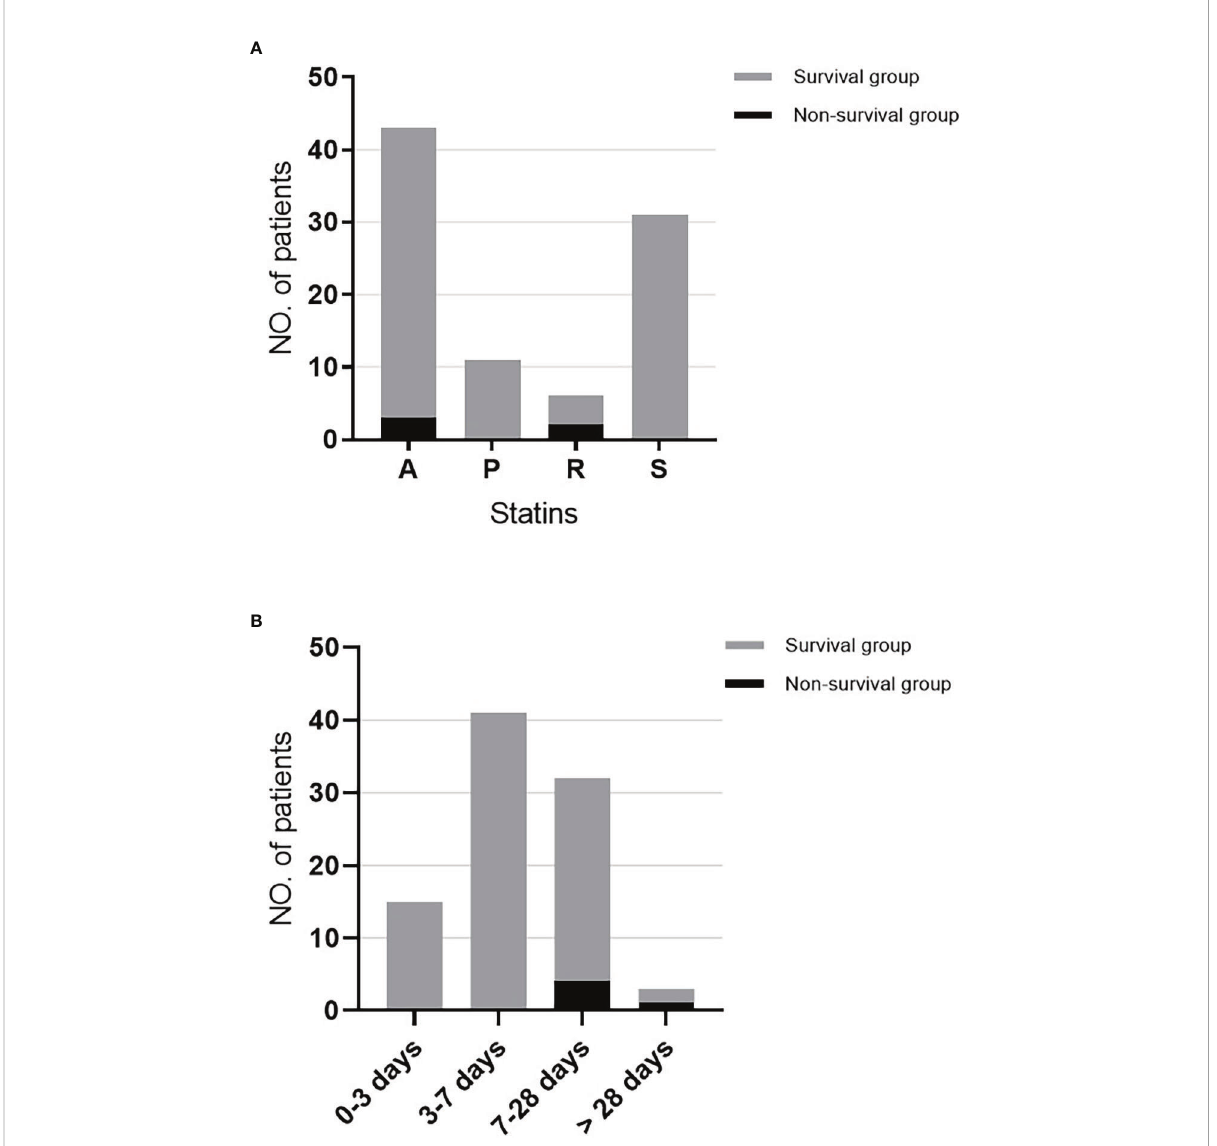
FIGURE 3 The use of statins and death within 28-day in statins use patients. (A) The distribution of statins categories and death within 28-day in statins use patients. (B) The distribution of statins duration and death within 28-day in statins use patients. A, Atorvastatin; P, Pravastatin; R, Rosuvastatin; S,